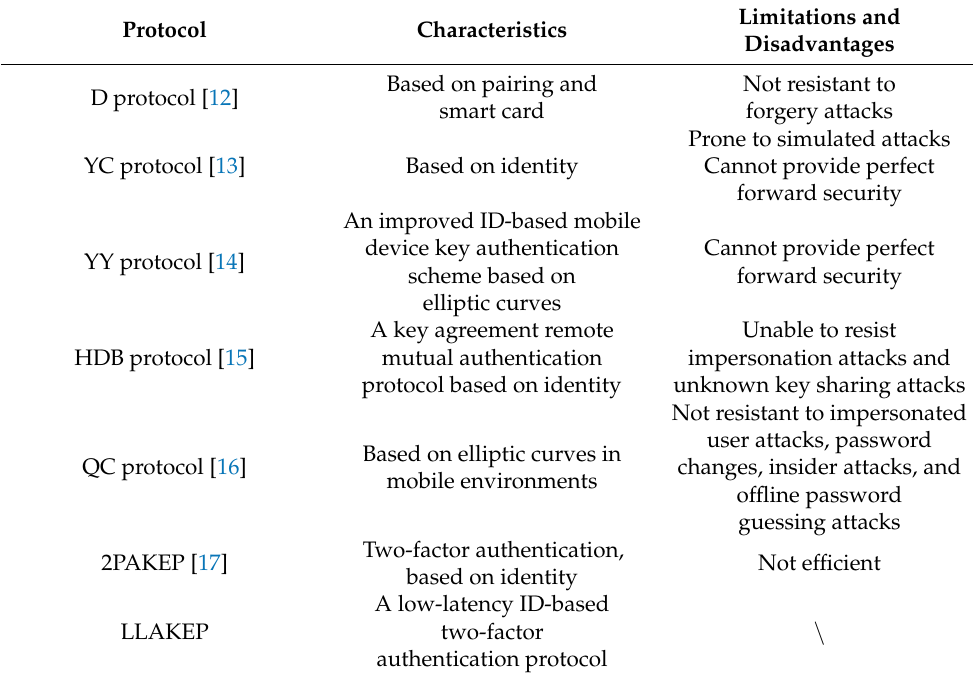
Table 1. Comparison of the characteristics, limitations, and disadvantages of different